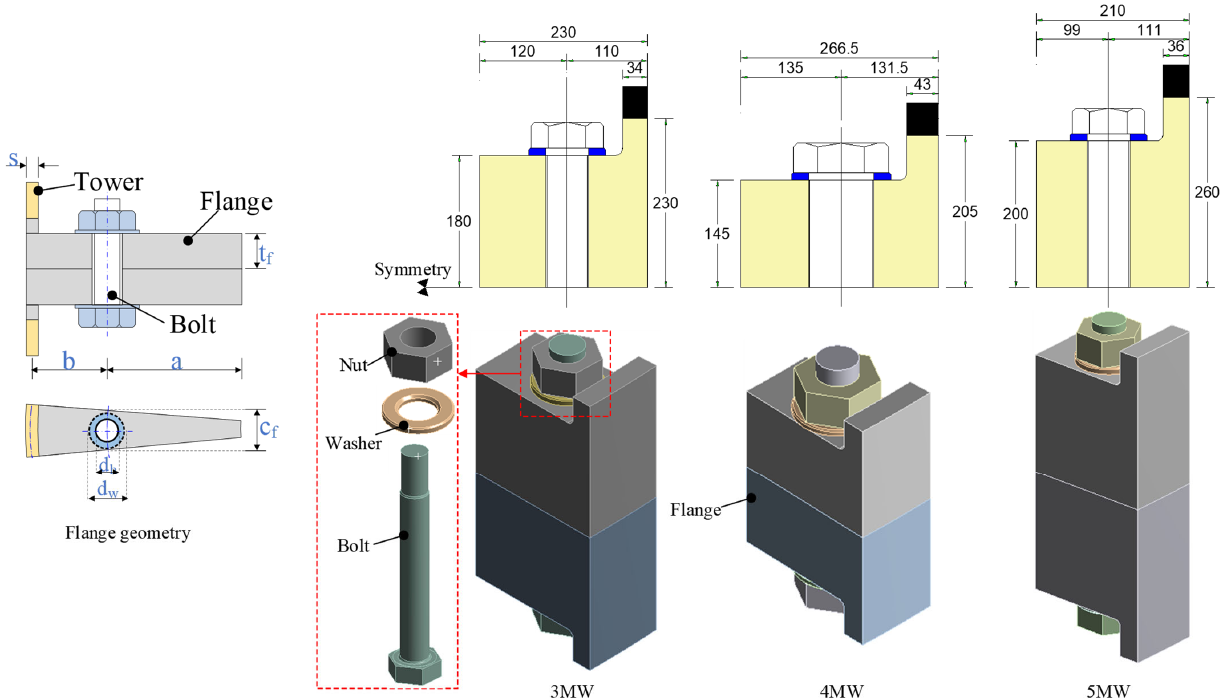
Figure 2. Geometry and corresponding finite element modeling of flange joints. Table 1. Geometry of the existing flange